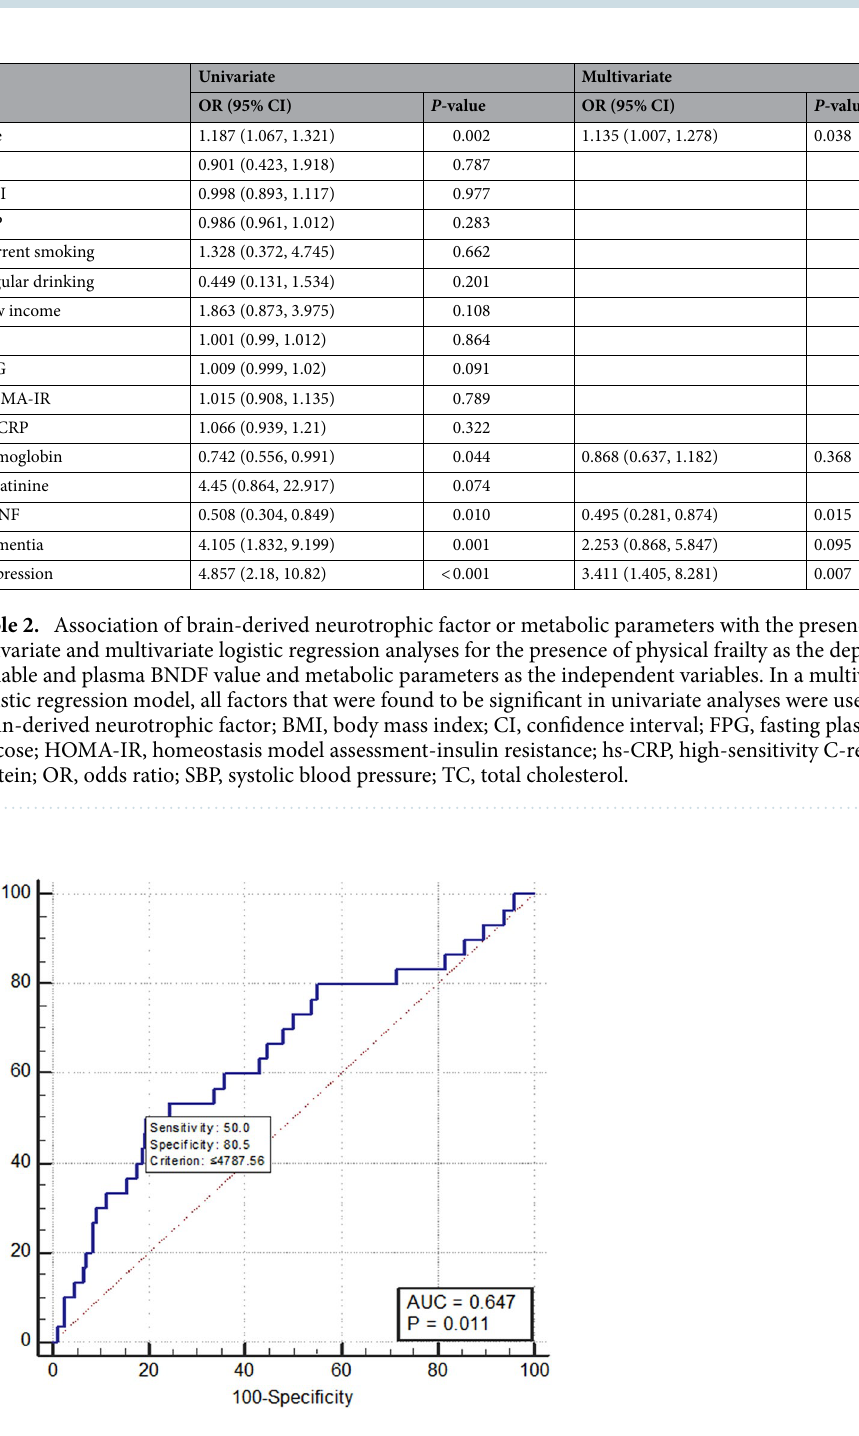
Figure 2. Receiver operating characteristic curves of plasma brain-derived neurotrophic factor levels for estimating